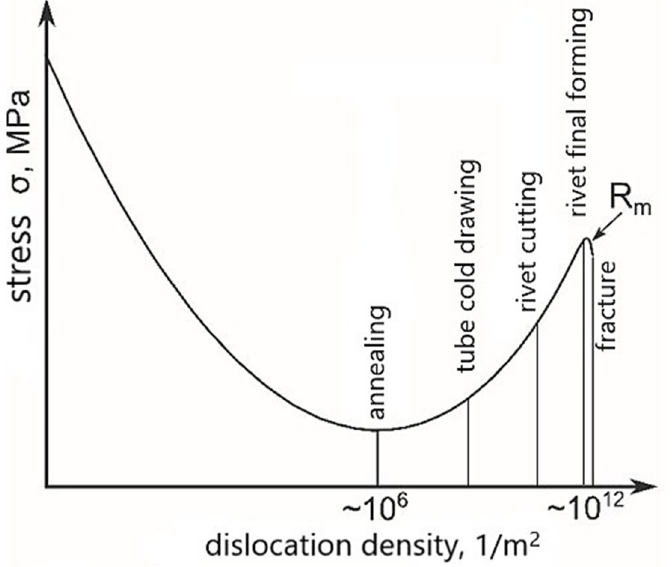
Figure 12. Effect of surface layer defects on the strength properties of the rivet material after various stages of the production process and final riveting.